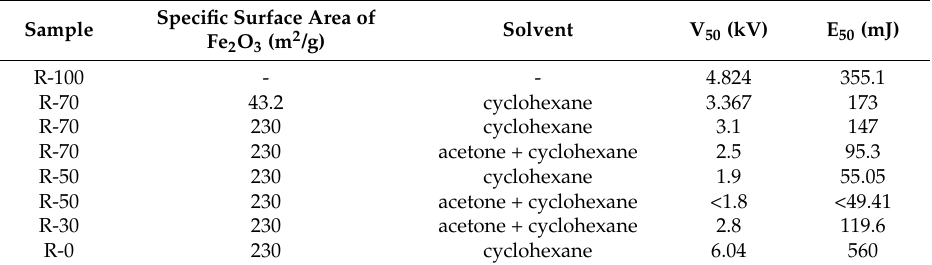
Table 2. Static discharge sensitivity of Al/Fe 2 O 3 /RDX nanocomposites.